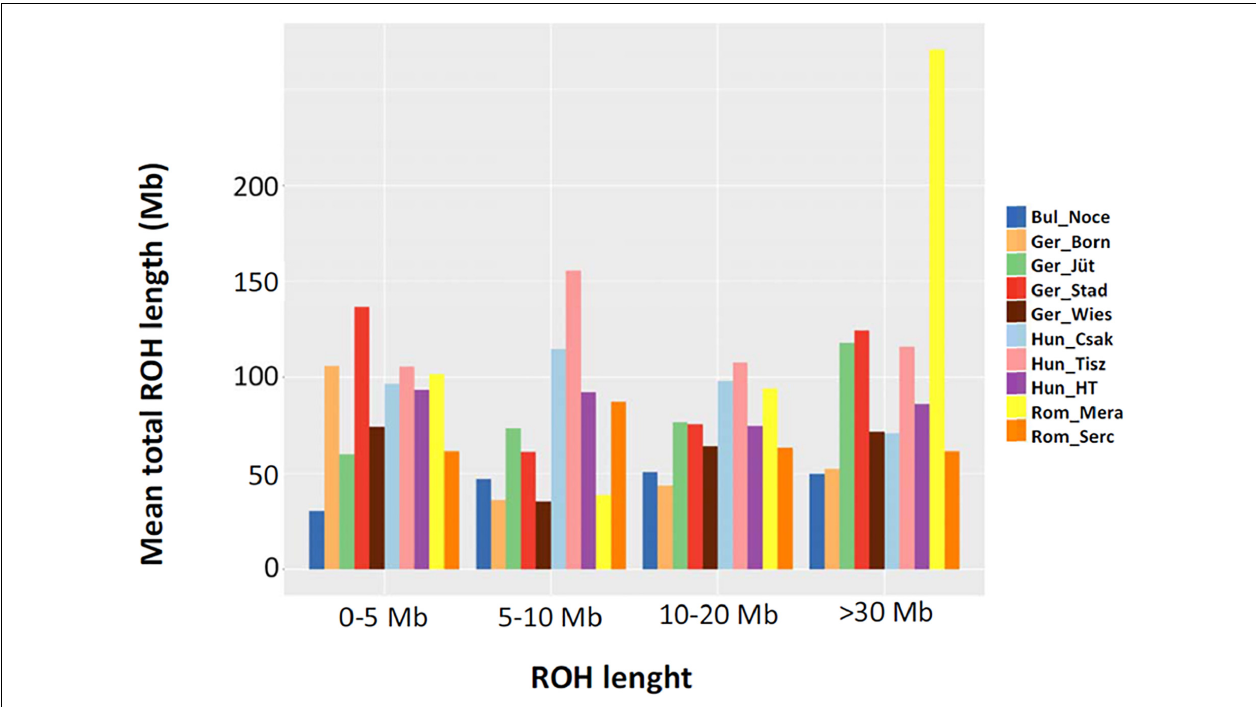
FIGURE 6 | The mean sum of runs of homozygosity (ROH) per population within each ROH length category in samples collected from buffalos in Bulgaria (Bul_Noce), Romania (Rom_Mera, Rom_Serc), Hungary (Hun_Csak, Hun_Tisz, Hun_HT), and Germany (Ger_Born, Ger_Jüt, Ger_Stad, Ger_Wies). Data include 61,813 SNPs genotyped in 285 samples (Mb: megabase); all other abbreviations and sample numbers are specified in Figure 3